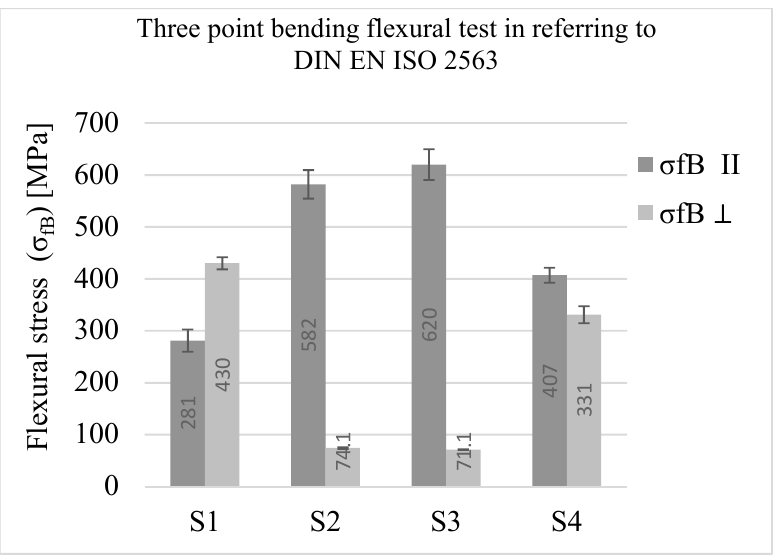
Figure 3. Apparent flexural stress σ fB measured in the longitudinal and perpendicular directions of the main sample axis.